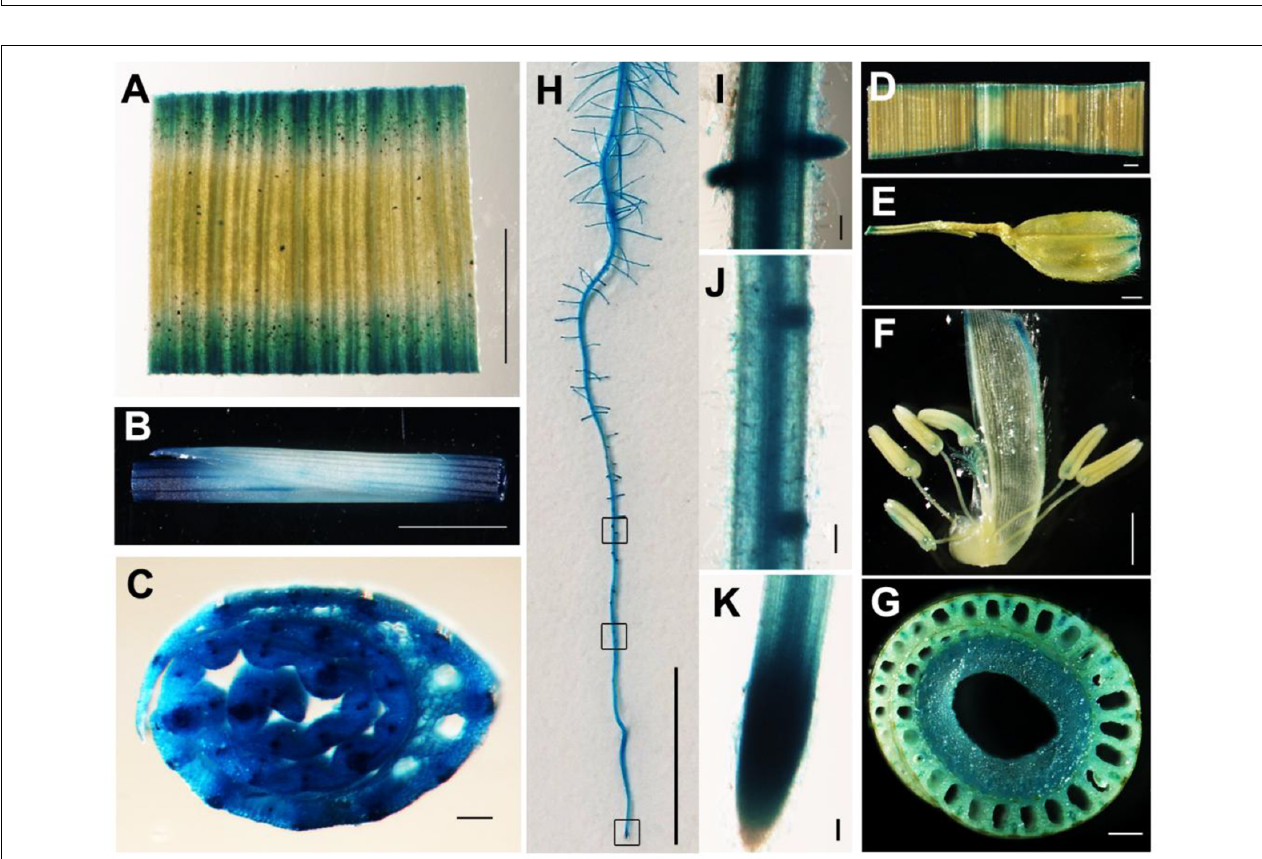
FIGURE 6 | Tissue expression pattern of YLC3 . (A–C,H–K) GUS staining of 7-day-old ProYLC3:GUS transgenic seedlings. (A) Leaf. (B) Stem. (C) Cross section of stem. (H) Primary root. (I) Lateral root. (J) Lateral root primordium. (K) Root tip. (D–G) GUS staining of the heading stage of ProYLC3:GUS transgenic plants. (D) Leaf. (E) Glume. (F) Anthers and pistils. (G) Cross section of stem. Scale bars are 100 µ m in (C,D,E,I–K) , 1 mm in (A,B,F,G) , and 1 cm in (H) .